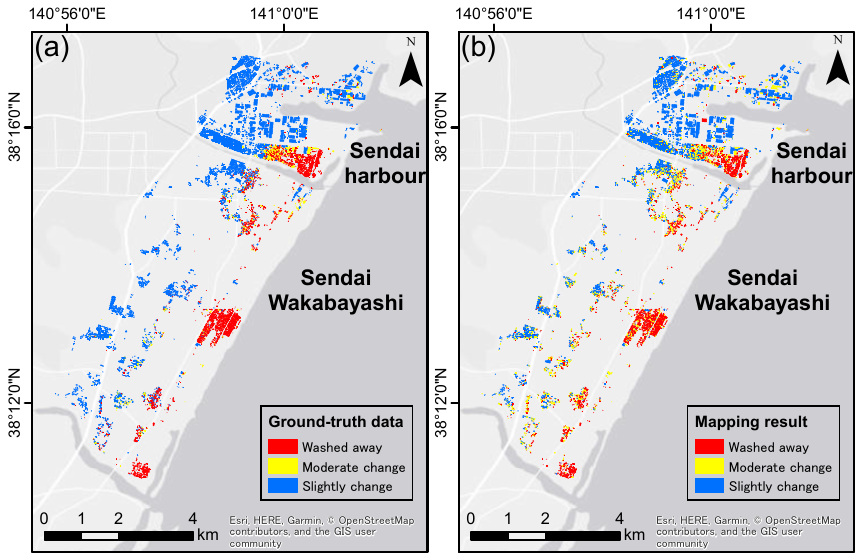
Figure 6. Mapping result of Scheme 1: ( a ) ground truth data; and ( b ) mapping result.